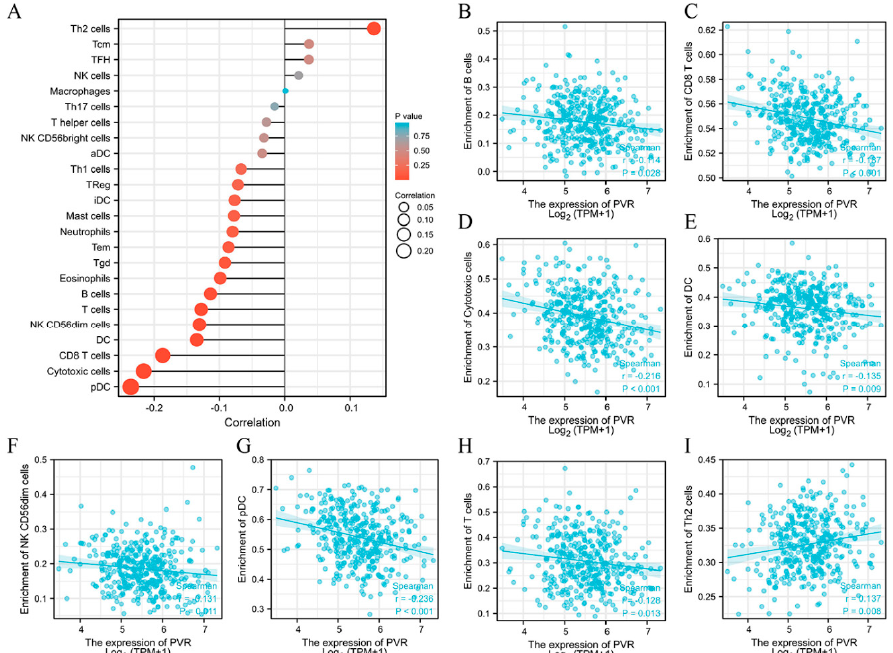
Figure 6. Correlation between PVR expression and immune cell infiltration. ( A ) Lollipop chart of PVR expression level in 24 immune cells. ( B – I ) Correlation between PVR expression and B cells, CD8+ T cells, cytotoxic cells, DC, NK CD56dim cells, pDC, T cells, and Th2 cells.